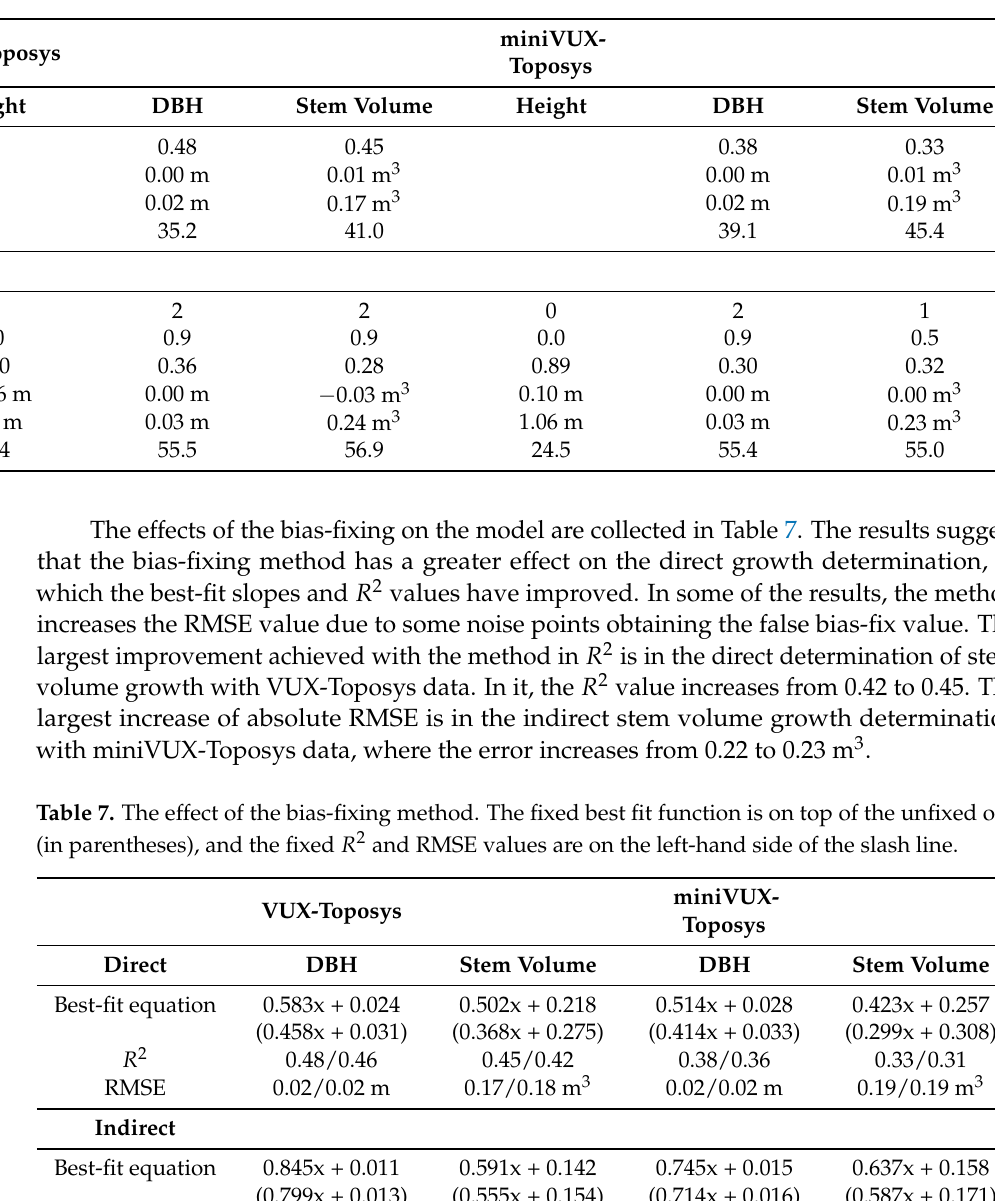
Figure 8. The bar graphs show that the mean of predicted growth values in an interval are very close to the mean reference growth values if the number of samples in an interval is high. If the number of samples is low, the mean predicted growth values deviate more from the mean reference growth values. This is not the case with mean height growth, where a low number of samples does not have such an effect on the accuracy of mean predicted growth, which is to be expected due to the more accurate